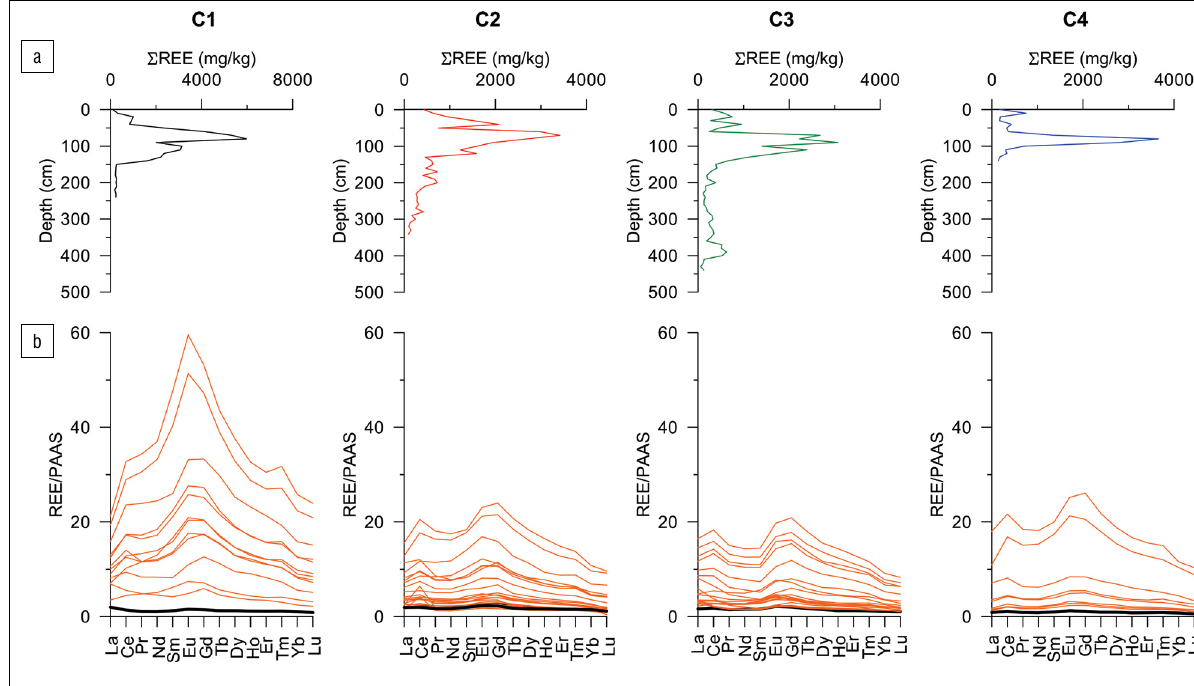
Figure 5: (a) Downcore total rare earth element (∑REE) concentration profiles for sites C1–4 and (b) Post-Archaean Australian Shale (PAAS)-normalised REE patterns. REE-enriched samples (REE/PAAS >1) are shown in orange, while the average of non-enriched samples is indicated in